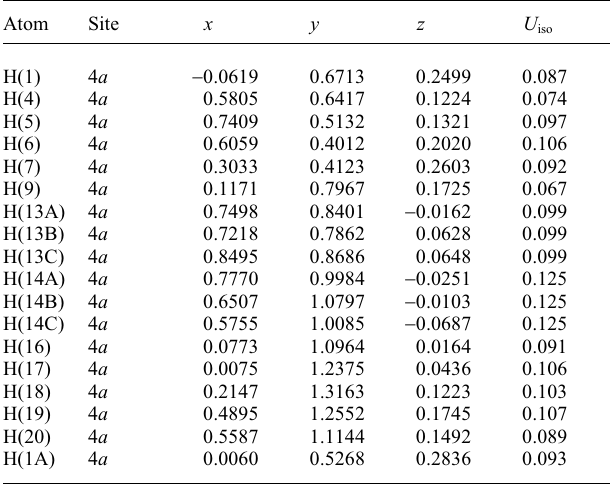
Table 2. Atomic coordinates and displacement parameters (in Å 2 )